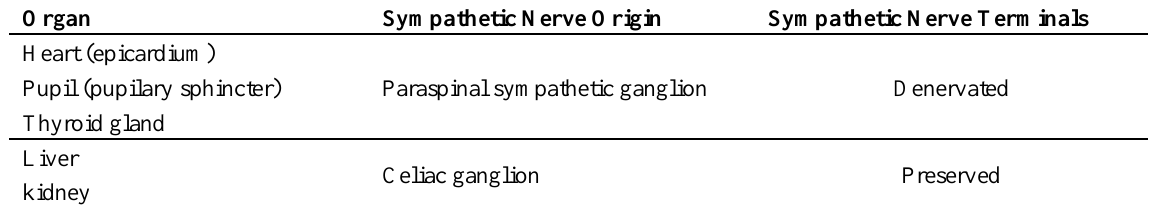
Table 4. Organs and sympathetic nerve terminals.